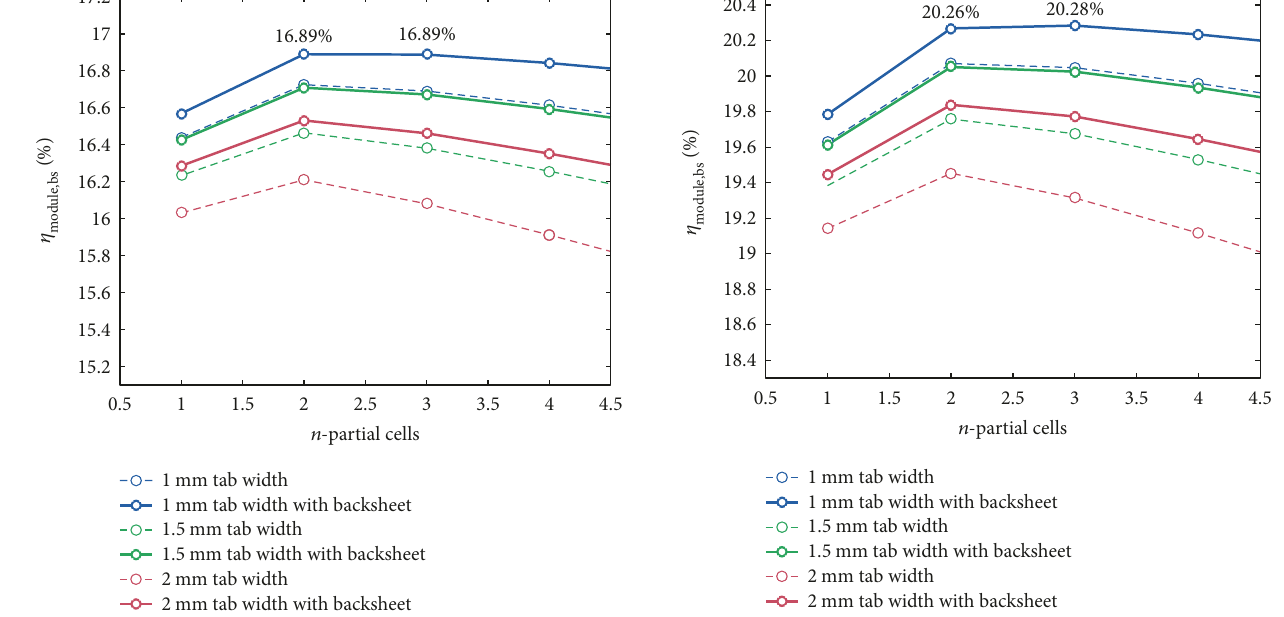
Figure 10: Backsheet and tab width-adjusted e ffi ciency (35mA/cm 2 ). Figure 11: Backsheet and tab width-adjusted e ffi ciency (42mA/cm 2